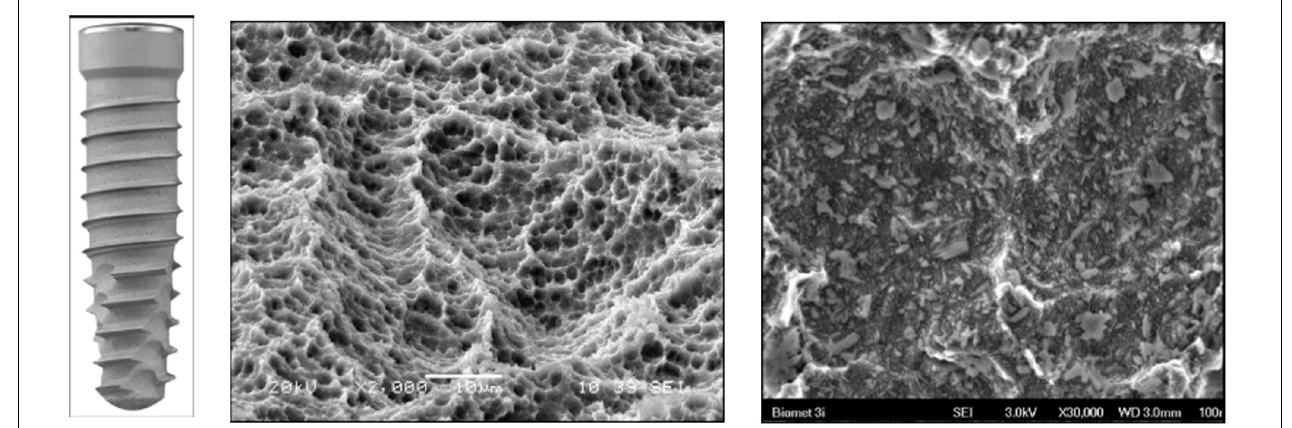
FIGURE 4 | Surface features and scanning electron micrographs of a BIOMET dental implant surface.